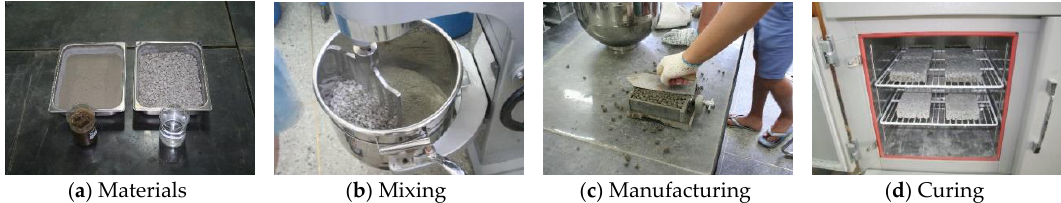
Figure 4. Test specimen production of the porous concrete produced with (D)PAOs and zeolite.